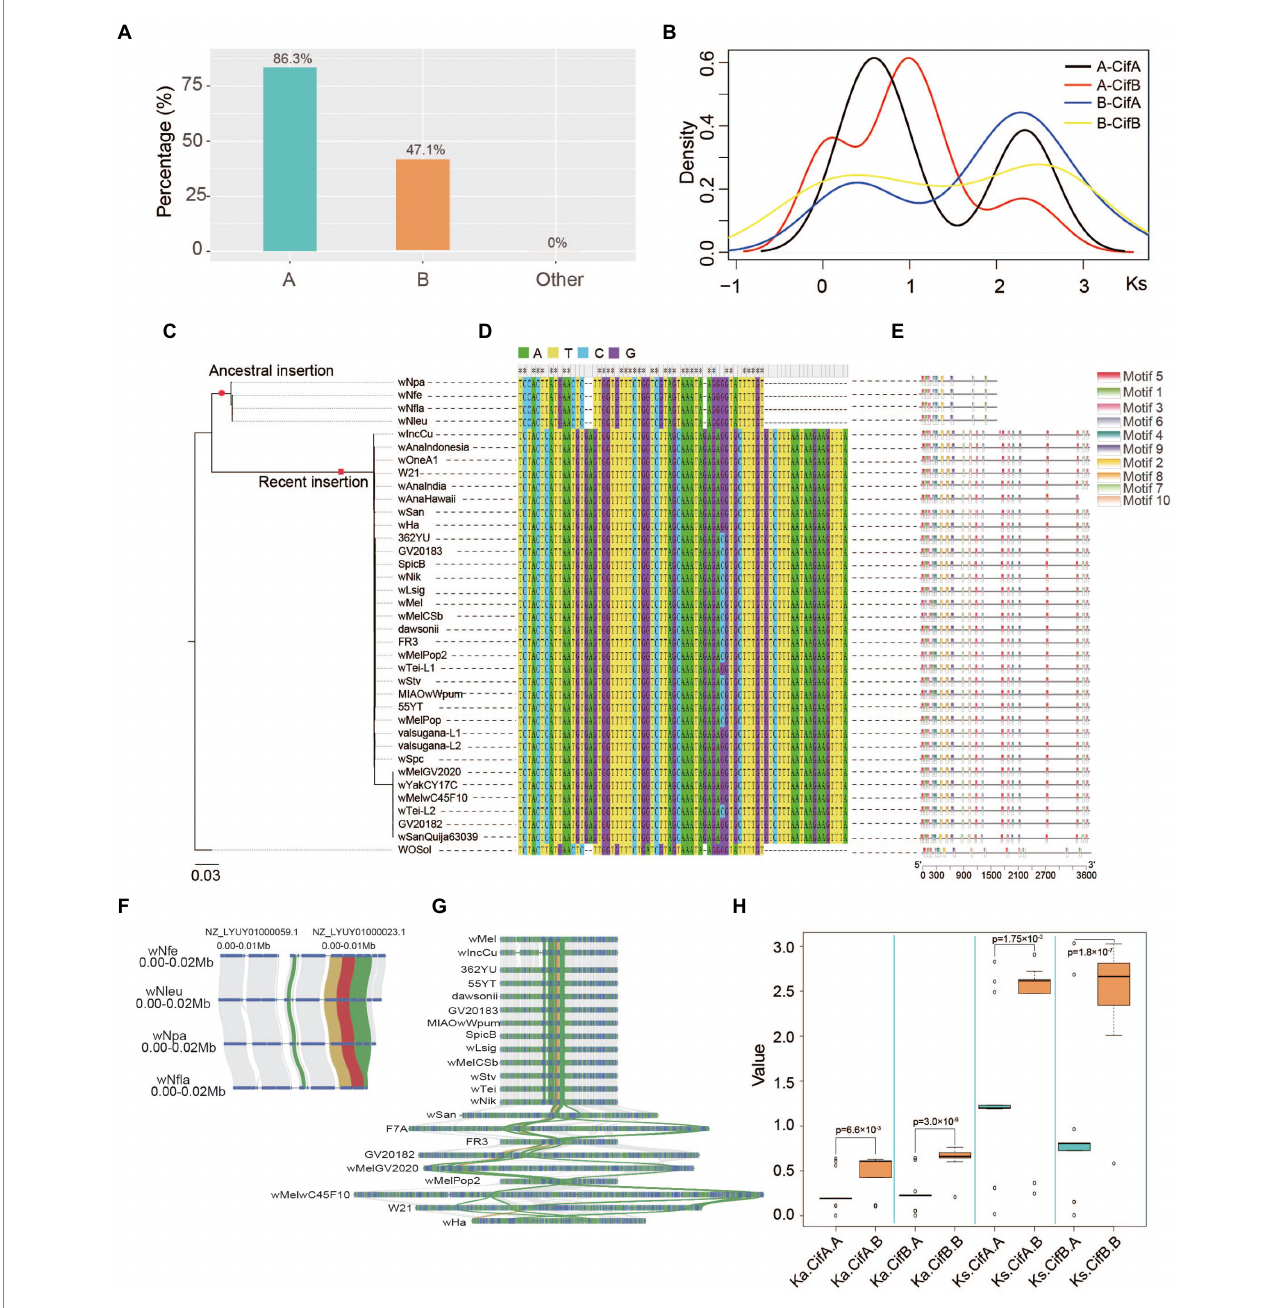
FIGURE 4 Evolution and diversity of Wolbachia cif genes in supergroups A and B. (A) Proportion of Wolbachia strains containing two cif genes in different supergoups. Supergroup A (green box), Supergroup B (orange box) and the other supergroups (red box) (B) Ks distribution of cif genes in Wolbachia supergroups A and B. A-CifA and A-CifB indicate the Ks distribution of cifA and cifB genes, respectively, between two strains in supergroup A. B-CifA and B-CifB indicate the Ks distribution of cifA and cifB genes, respectively, between two strains in supergroup B. (C) Maximum likelihood tree of cifB genes in supergroup A strains that contained both cif genes. The red circle represents the ancient cif gene insertion event. The red square represents the recent cif gene insertion event. (D) Multiple sequence alignment of intergenic sequences between two cif genes. (E) Motif composition of the cifB gene-encoding sequence. Each colour box of rectangle represents a different motif. The dials at the bottom indicate the length of the coding sequence. (F) Microsyntenic graph of ancient insertions with the same haplotype in Wolbachia genomes. The red and yellow lines represent the syntenic relationships of the cifA and cifB genes, respectively. The green and grey lines represent the syntenic relationships of phage WO and Wolbachia genes, respectively. The blue boxes indicate genes in each strain genome. (G) Microsyntenic graph of recent insertions with the same haplotype in Wolbachia genomes. The red and yellow lines represent the syntenic relationships of the cifA and cifB genes, respectively. The green and grey lines represent the syntenic relationships of phage WO and Wolbachia genes, respectively. The blue boxes indicate genes in each strain genome. (H) Comparison of the synonymous mutation rate ( K s ) and nonsynonymous mutation rate ( K a ) in Wolbachia supergroups A and B. ka.cifA. A indicates the K a values of cifA gene between two strains in supergroup A. ka.cifB. B indicates the K a values of cifB gene between two strains in supergroup B, ks.cifA. B indicates the K s values of cifA gene between two strains in supergroup B, ks.cifB. A indicates the K s values of cifB gene between two strains in supergroup